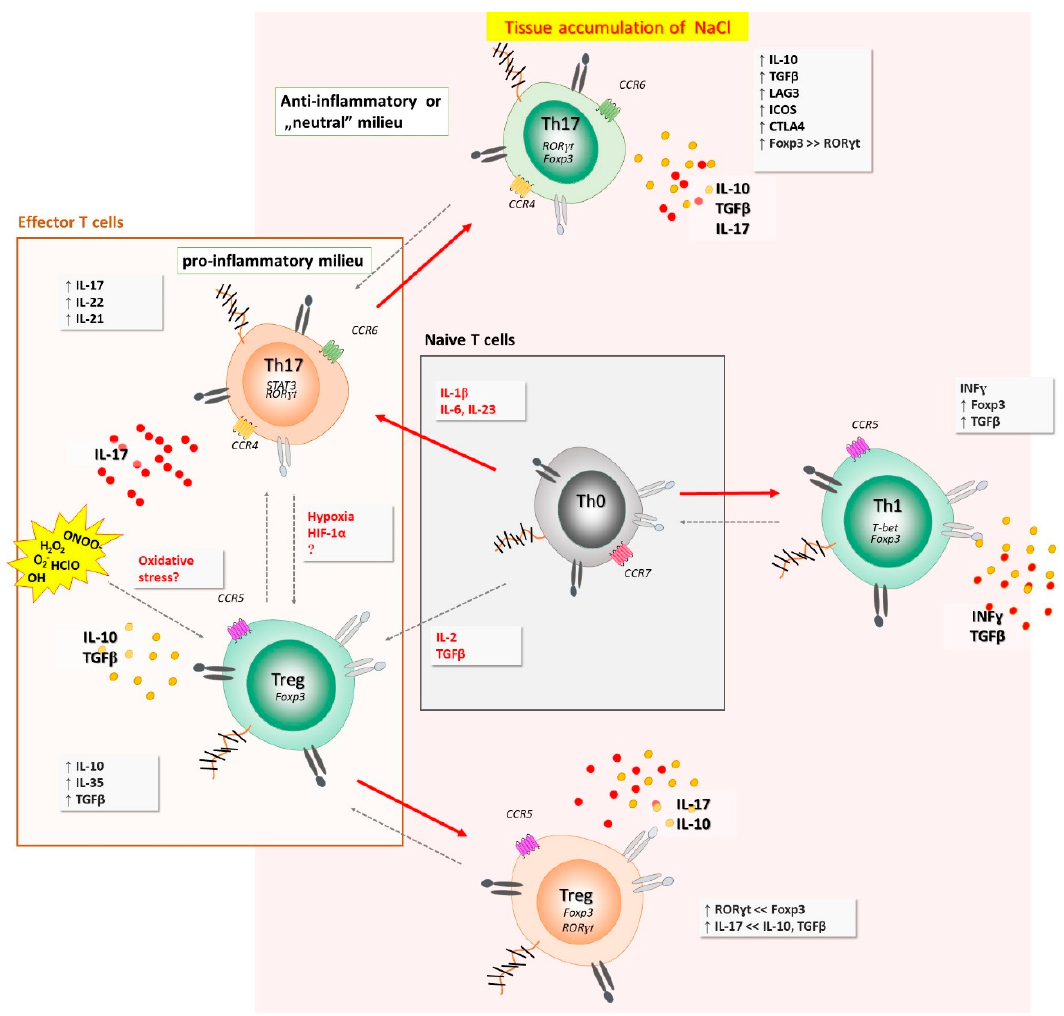
Figure 6. Dichotomous, context ‐ dependent fate of T helper cells, when exposed to high ‐ salt condi ‐ tions. Naïve cell, exposed to hyperosmotic and pro ‐ inflammatory environment, primed under Th17 polarizing cytokines, acquired enhanced Th17 function. This effect was also observed among other T helper cell compartments (i.e., Th1 subpopulation). Interestingly, if the Th17 cells are void of pro ‐ inflammatory milieu during activation in high NaCl environment (and re ‐ activation at the sites of ongoing immune responses against certain pathogens or (auto)antigens), they acquire anti ‐ inflam ‐ matory phenotype and function, characterized by the up ‐ regulation of IL ‐ 10, TGF β , Foxp3, CTLA ‐ 4, ICOS, and LAG3. Increased oxidative stress may alter immune regulatory mechanisms, poten ‐ tially via effects on Treg cells.